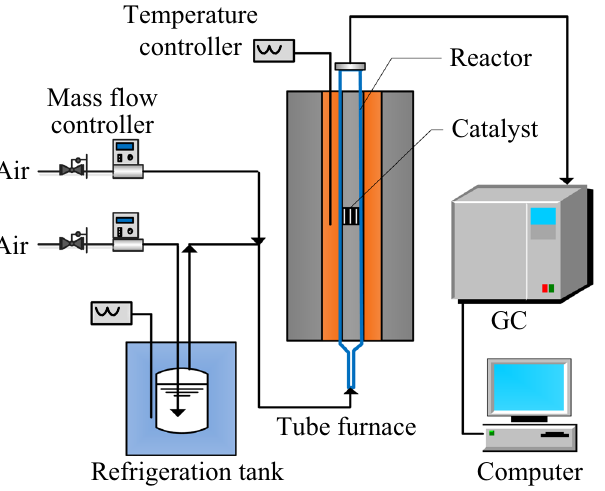
Figure 1. Schematic diagram of catalysts evaluation